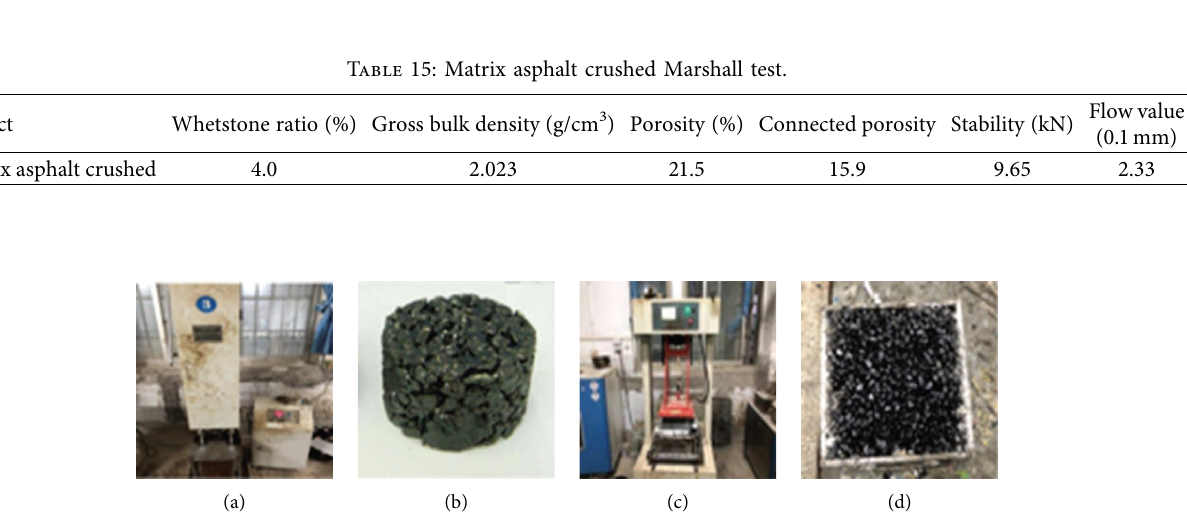
Figure 1: Formation of the specimen: (a) Marshall compactors. (b) Marshall specimen. (c) Te rolling of the matrix asphalt macadam. (d) Te formation of the matrix asphalt